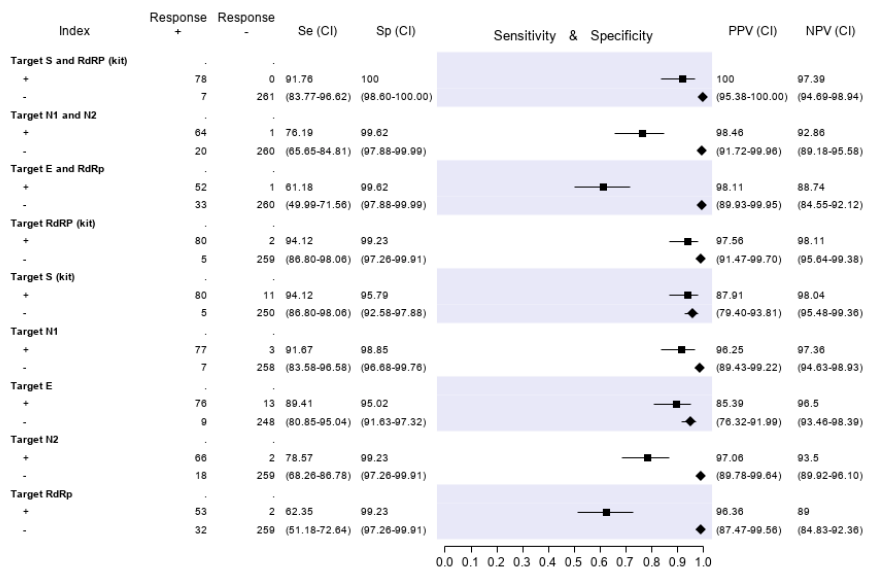
Figure 3. Sensitivity (filled squares), specificity (filled rhombus) and predictive values of three molecular tests and of single gene targets, according to the final classification (Infected = 85, not infective = 261). “Target S and RdRp (kit)” corresponds to the RealQuality RQ-SARS-nCoV-2 assay (cod. RQ-130, AB Analitica, Italy), targeting the spike protein gene ( S ) and the RNA-dependent RNA polymerase gene ( RdRp ). “Target N1 and N2” corresponds to the CDC 2019-Novel Coronavirus (2019-nCoV) Real-Time RT-PCR Diagnostic Panel, targeting the nucleocapsid protein gene ( N ), regions N1 and N2 . “Target E and RdRp” corresponds to the in-house RT-PCR protocol, targeting the envelope protein gene ( E ) and the RdRp . +, positive result; –, negative result; Se, sensitivity; Sp, specificity; PPV, positive predictive value; NPV, negative predictive value.